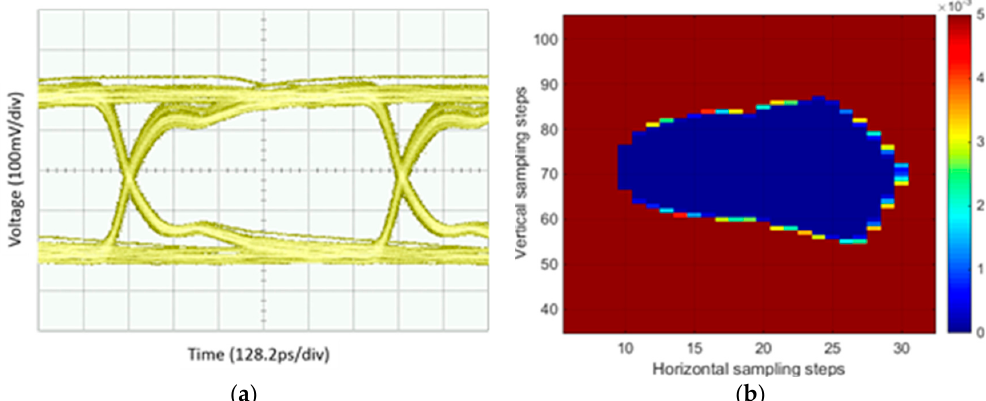
Figure 5. Digital signal waveform obtained using ( a ) an oscilloscope and ( b ) using BER.